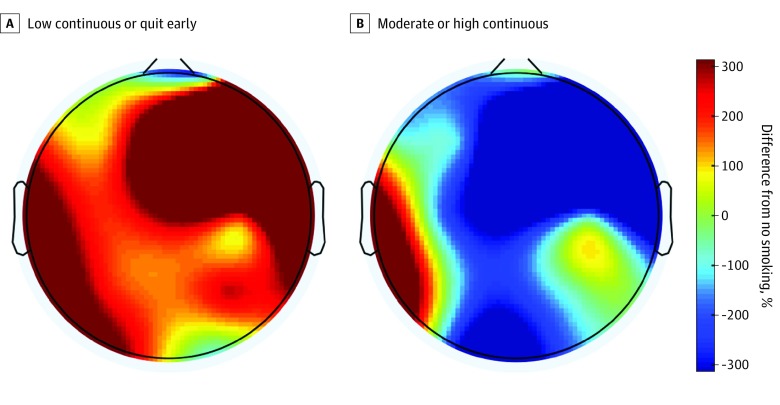
Main Effect of Smoking on Electroencephalography PowerMain effect of smoking at 19-21 Hz (beta) on newborn electroencephalography power representing the percent difference in power compared with no smoking based on estimated marginal means.